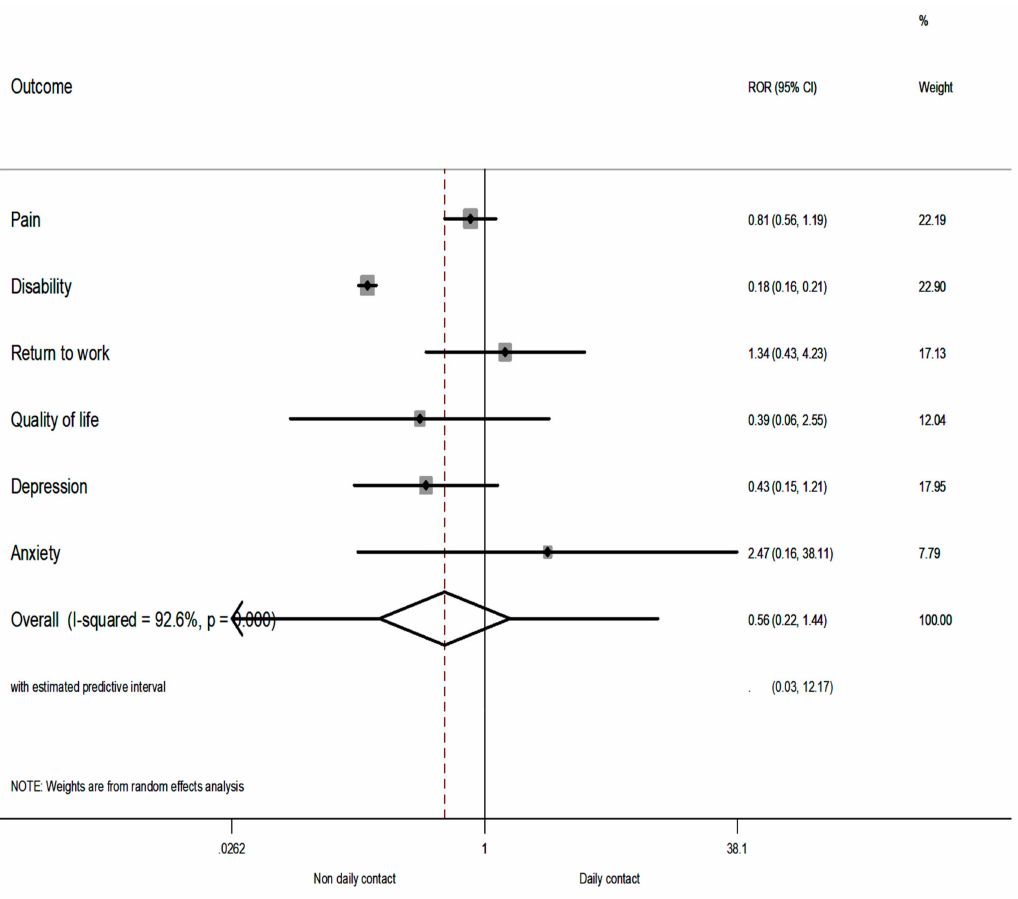
Figure 3. The relative odds ratios (RORs) and 95% confidence intervals (CIs) for each outcome, and the summary RORs and their 95% CIs at short term of non-daily contact vs. daily contact. The RORs were calculated with a random-e ff ects model. A ROR > 1 favours daily contact; an ROR < 1 favours non-daily